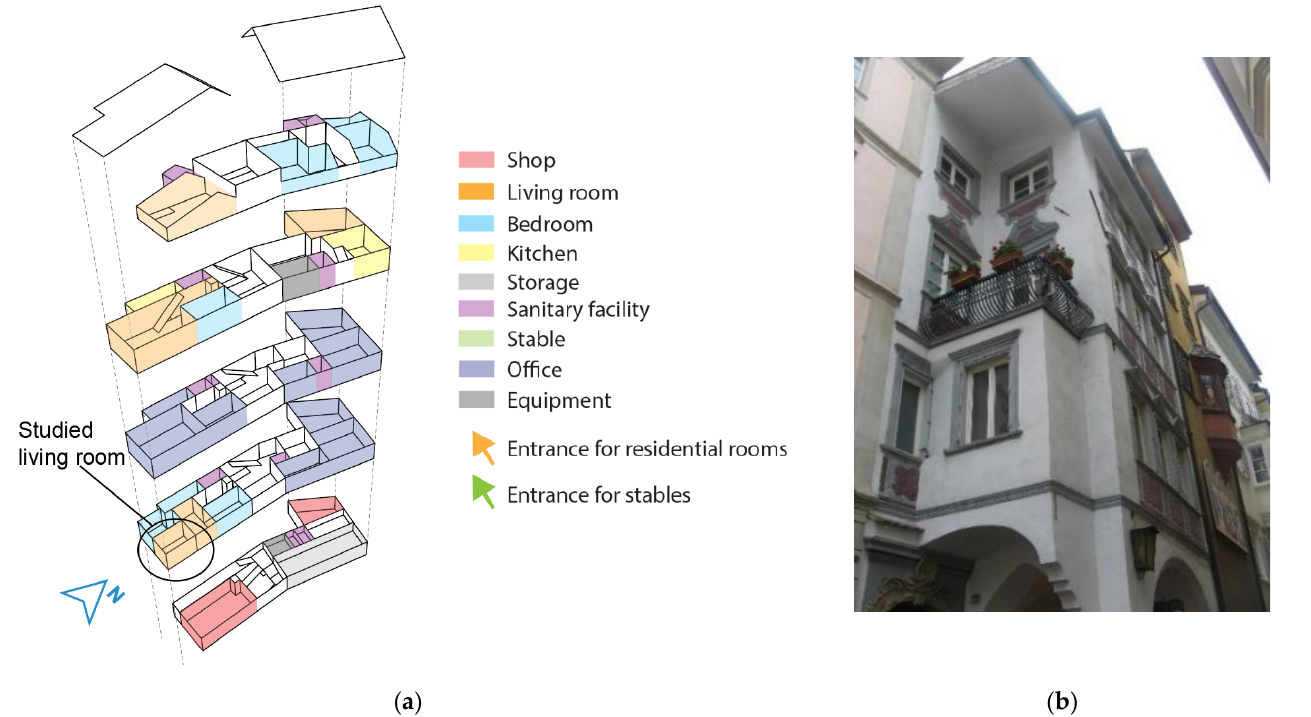
Figure 3. Architectural layout ( a ) and photograph ( b ) of the Portici house in Climate zone I. Table 3. Key architectural details of the reference buildings. W-to-W ratio = window-to-wall ratio.